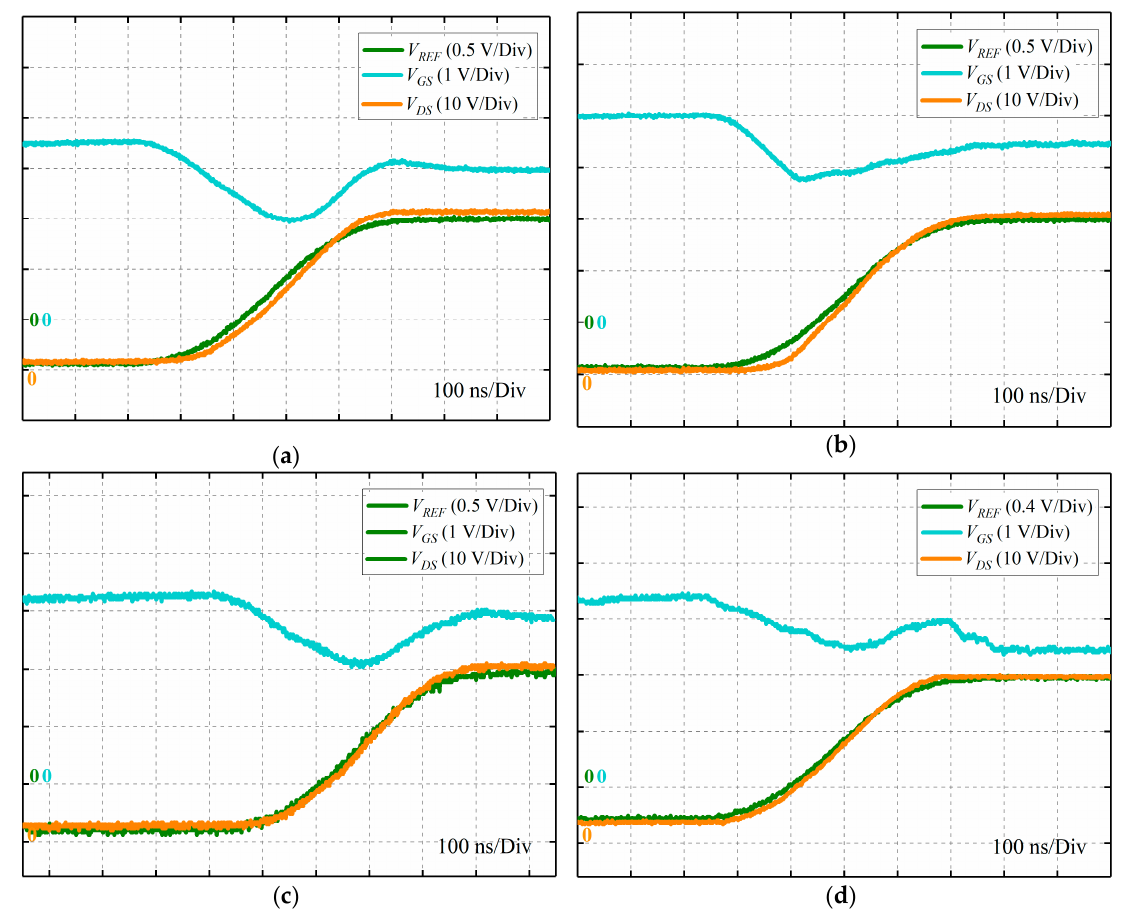
Figure 5. Turn-off switching transient waveforms of power MOSFET: ( a ) V DS , V REF , and V GS waveforms under Design I; ( b ) V DS , V REF , and V GS waveforms under Design II; ( c ) V DS , V REF , and V GS waveforms under Design III; ( d ) V DS , V REF , and V GS waveforms under Design IV.